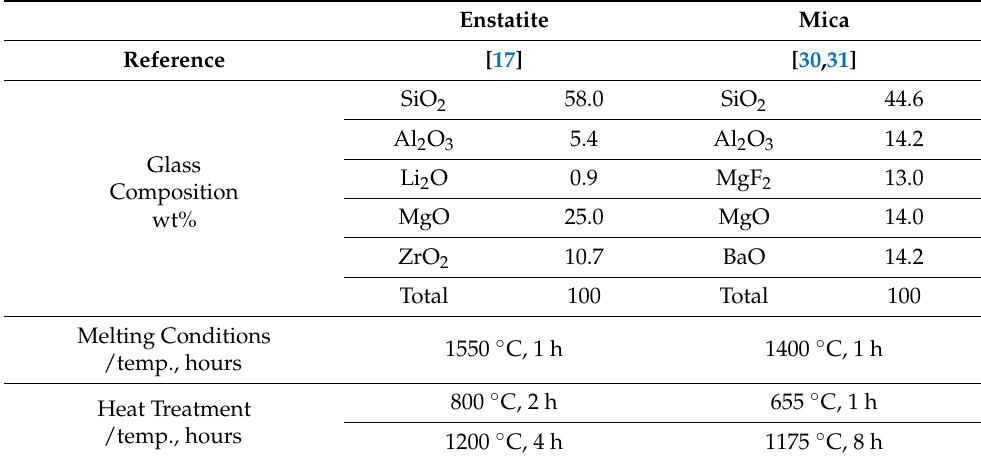
Table 2. Precursor glass compositions used in this study as